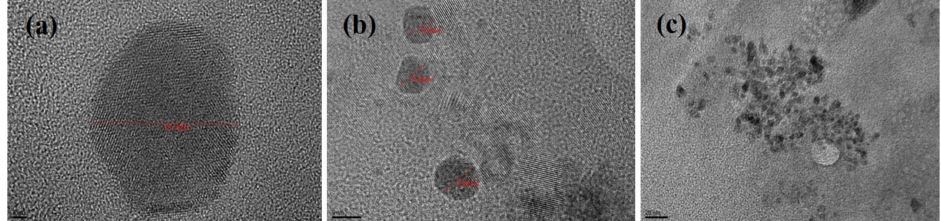
Figure 4. TEM micrographs of green tea extract-loaded nanophytosomes (batch 15) scales showing ( a ) 2 nm, ( b ) 5 nm and ( c ) 20 nm range.